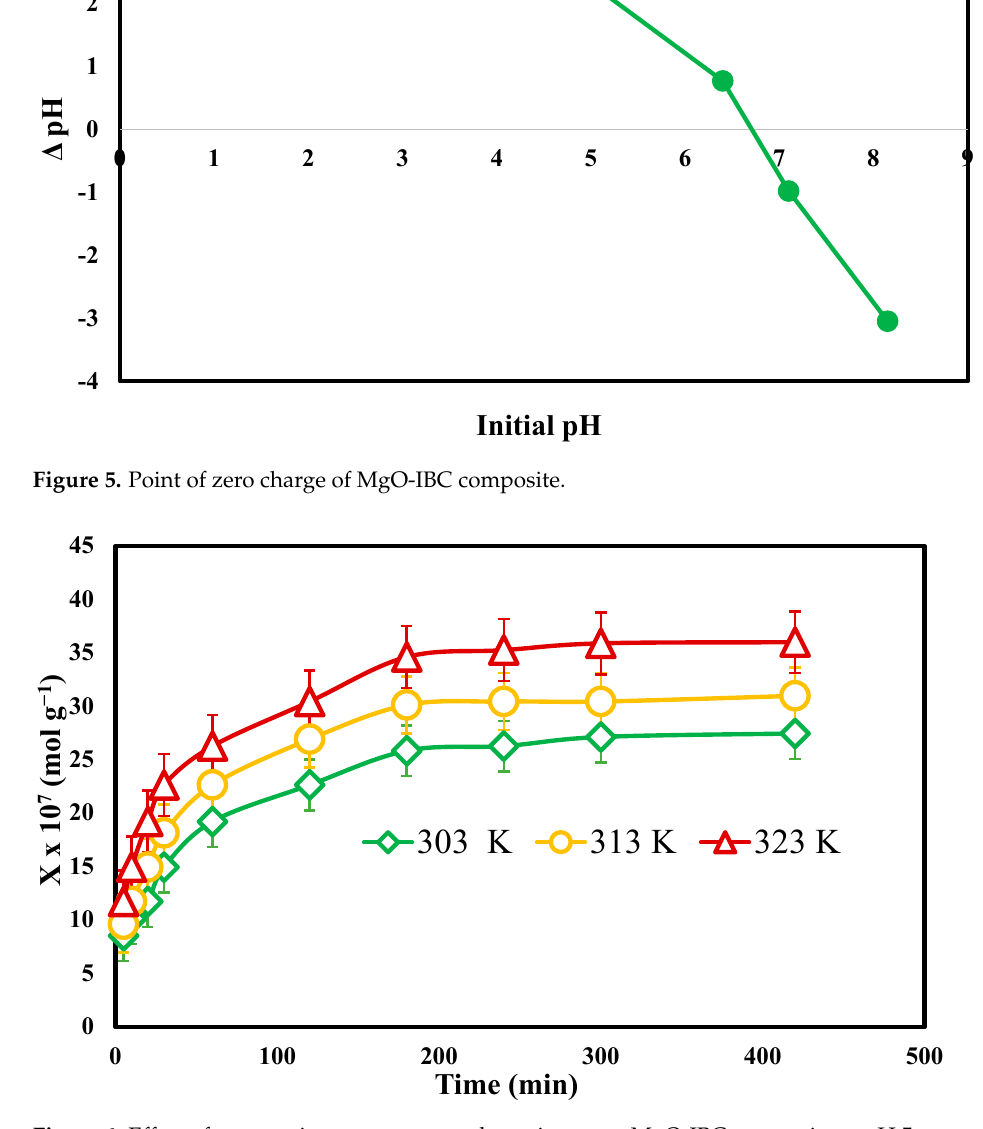
Figure 6. Effect of contact time on arsenate adsorption on to MgO-IBC composite at pH 5.